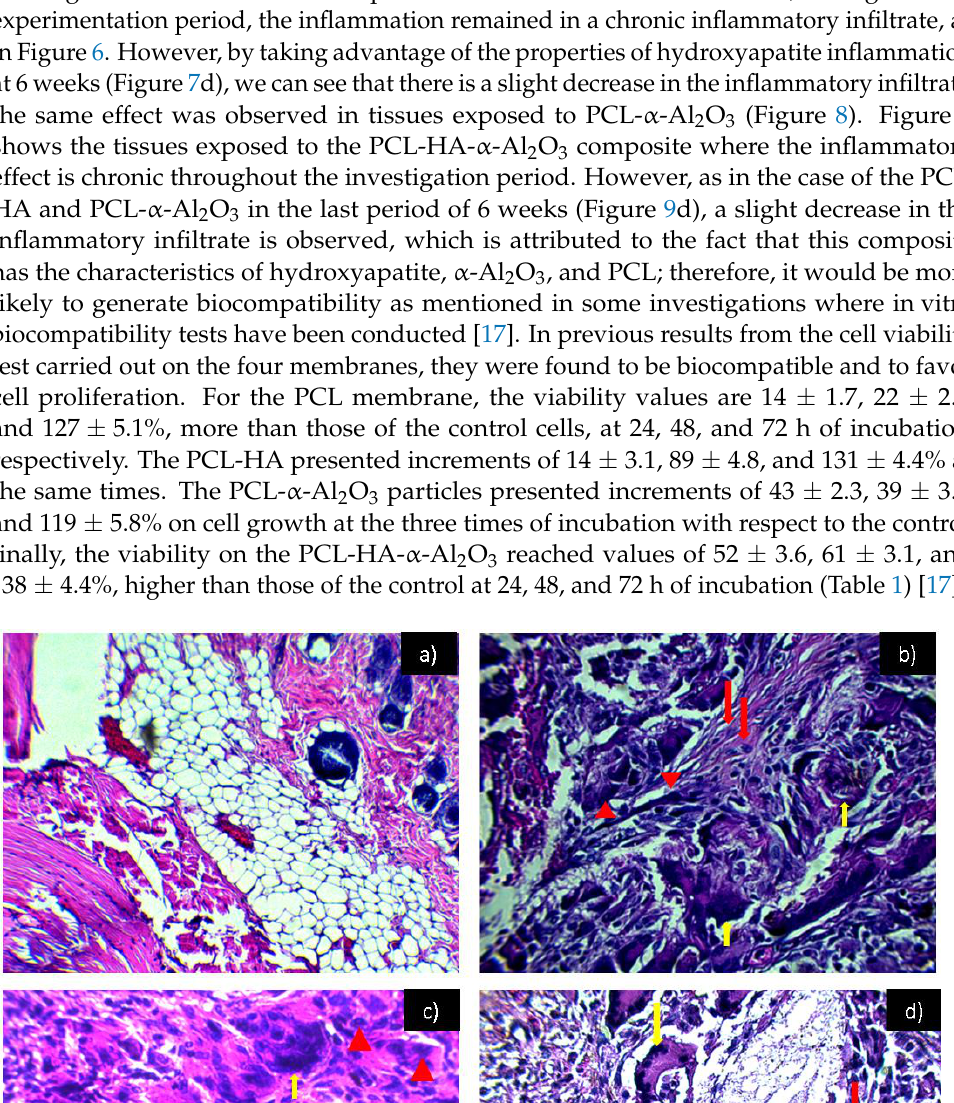
Figure 8. Histological preparation in tissue hematoxylin-eosin with the PCL/ α -Al 2 O 3 : ( a ) control, ( b ) PCL/ α -Al 2 O 3 2 weeks, ( c ) PCL/ α -Al 2 O 3 4 weeks, and ( d ) PCL/ α -Al 2 O 3 6 weeks. Red arrows indi- cate the presence of lymphocytes, red arrowheads indicate macrophages, and yellow arrows indi- cate the presence of multinucleated giant cells characteristic of a chronic inflammatory infiltrate.